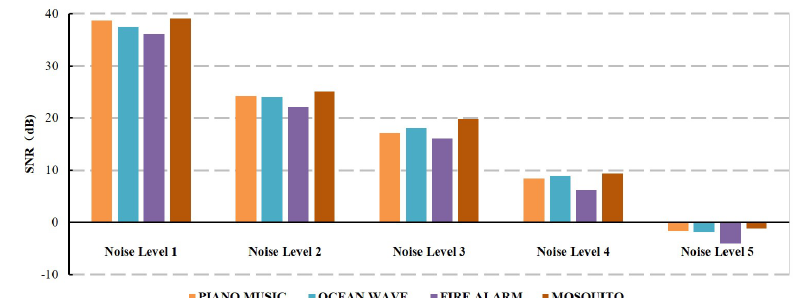
Figure 8. The SNR of audio stimulus materials.